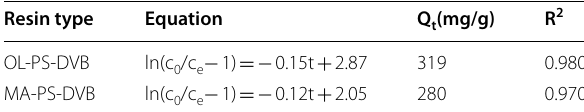
Table 4 Thomas model fitting results of OL‑PS‑DVB and MA‑PS‑